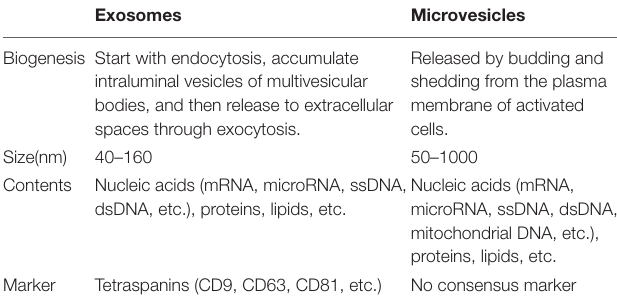
TABLE 1 | Characteristics of extracellular